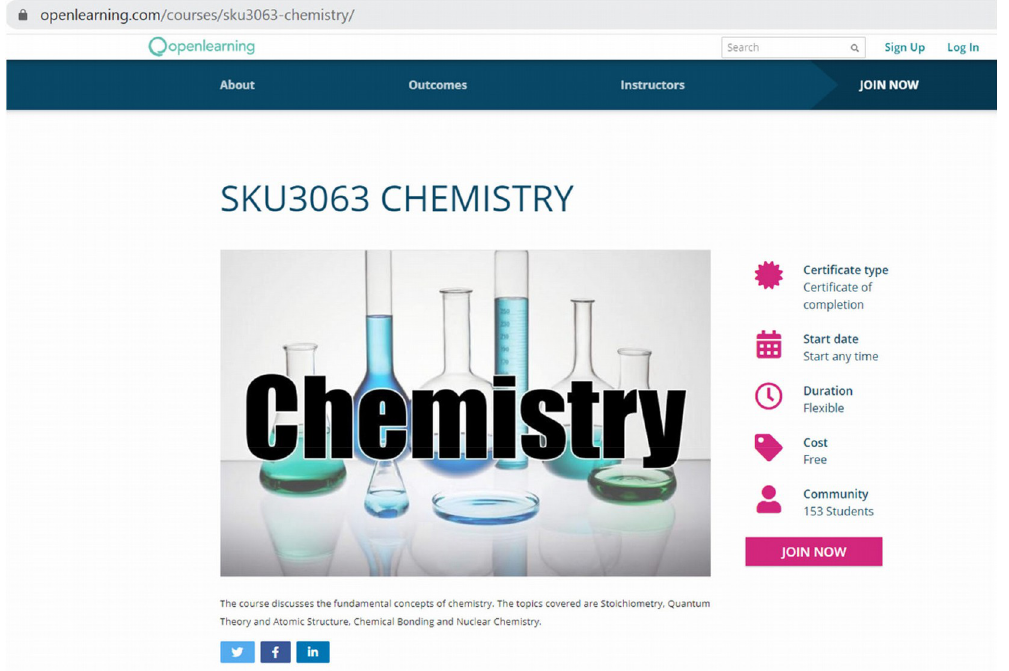
Figure 13. Promotional page of Chemistry